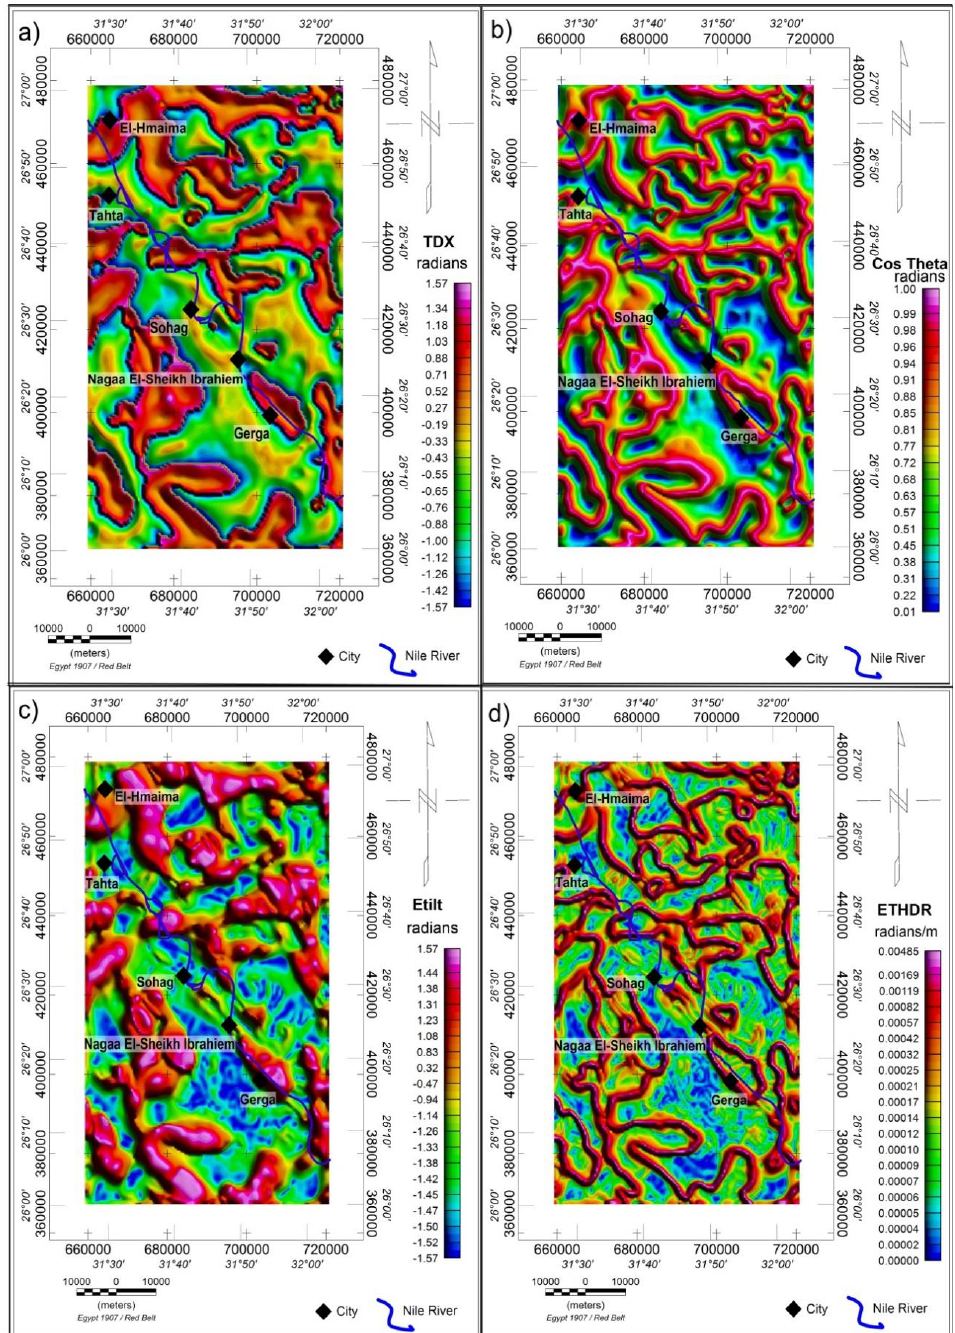
Figure 5. TDX ( a ), Cos Theta ( b ), ETilt ( c ), and enhanced total horizontal gradient of tilt angle (ETHDR) ( d ) maps of the investigated area.